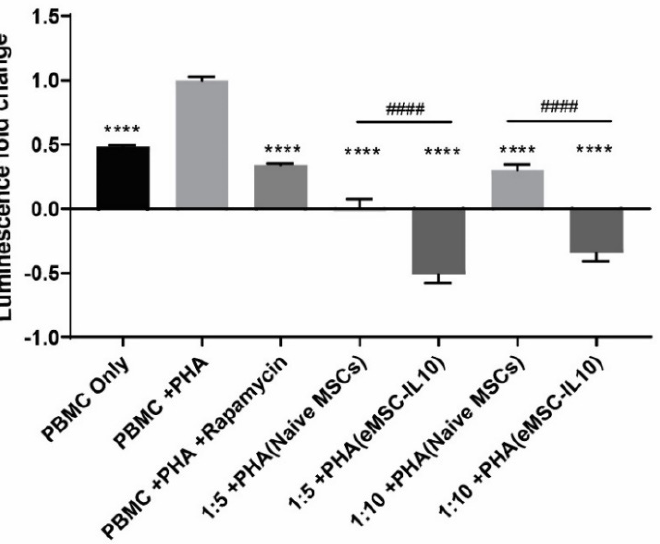
Figure 4. MSC immunosuppressive capacity in coculture potency assay. MSCs were incubated with PHA activated PBMCs in a 96-well plate with 1:5 and 1:10 cell ratios of MSC to PBMC. After 3 days of coculturing, the ATP content in each well was quantified and indicated by relative luminescence unit (RLU) value. The luminescence fold change was normalized to the PHA-stimulated PBMC group. Statistical differences were evaluated by one-way ANOVA. Data presented as mean ± SD ( n = 5), * indicates groups compared with PHA stimulated PBMC group, and # indicates comparisons between naïve MSC coculture groups and eMSC-IL10 coculture groups (1:5 or 1:10). **** p < 0.0001 and #### p < 0.0001.